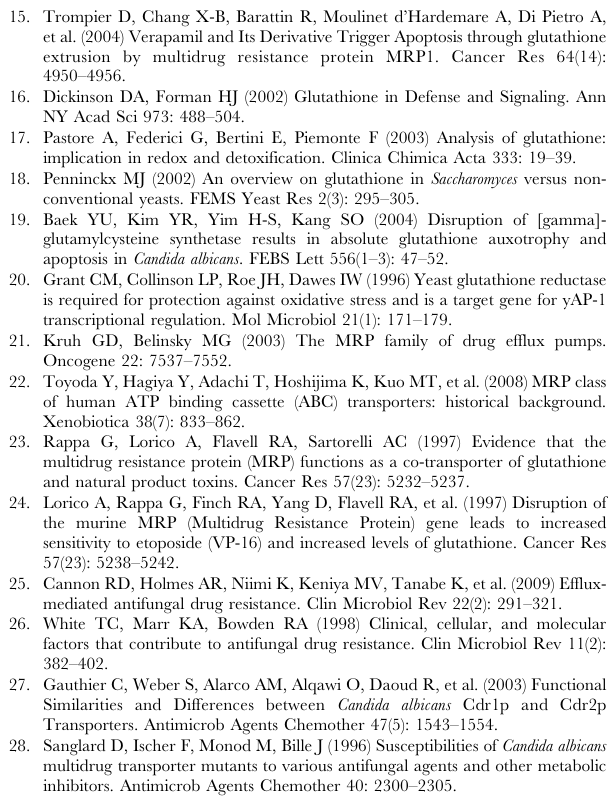
Figure S2 C. albicans cell density killing curve. Percent killing of C. albicans by farnesol was inversely proportional to cell density. Error bars indicate the standard errors of the means. Figure S3 Time course killing of C. albicans by farnesol. Percent killing of C. albicans was proportional to time of exposure to farnesol. However, the difference in level of killing between the different time points was not significant. Error bars indicate the standard errors of the means.